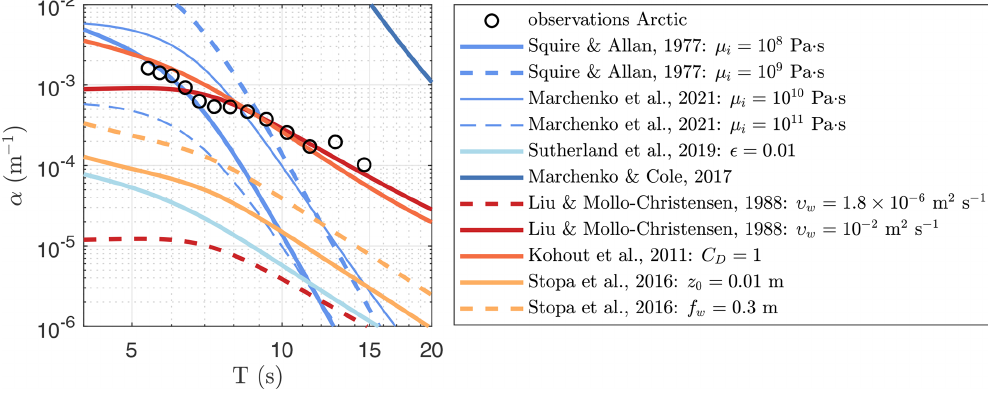
Figure 5. Comparison of wave attenuation rate α observed in the Arctic experiment against various wave dissipation models. These include models where dissipation is attributed to the ice layer (cool colour tones; Squire and Allan, 1977; Sutherland et al., 2019; Marchenko and Cole, 2017) and friction (warm colour tones; Liu and Mollo-Christensen, 1988; Kohout et al., 2011; Stopa et al.,